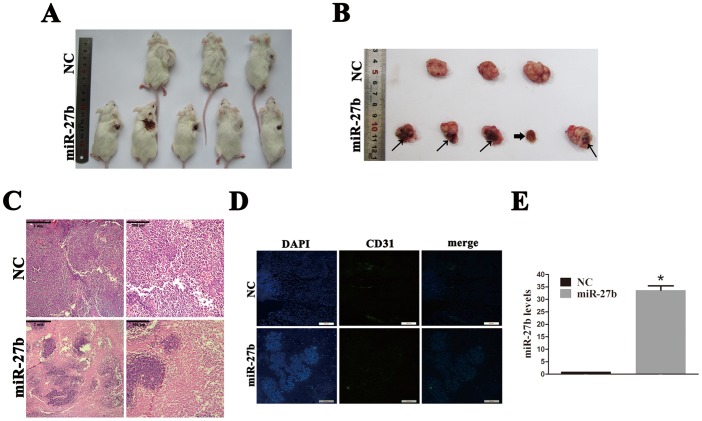
miR-27b has anti-tumor and angiogenesis effects in vivo.(A and B) Colorectal cancer (CRC) bearing NOD/SCID mice were intratumorally injected with cholesterol-conjugated negative control (NC) or miR-27b mimics. Scabs were observed in four tumors from the miR-27b group (fine arrow). One tumor from the miR-27b group disappeared completely with only a scab remaining (thick arrow). (C) Hematoxylin and eosin (HE) staining of xenograft tissues showing necrotic areas in the miR-27b group. (D) A representative immunofluorescence assay showing CD31 protein in xenograft tissues from NC and miR-27b (n = 3). Scale bars = 200 µm. (E) miR-27b expression in xenografts from NC and miR-27b mimics was assessed by qPCR. Error bars represent the means ± SEM, *P<0.05.